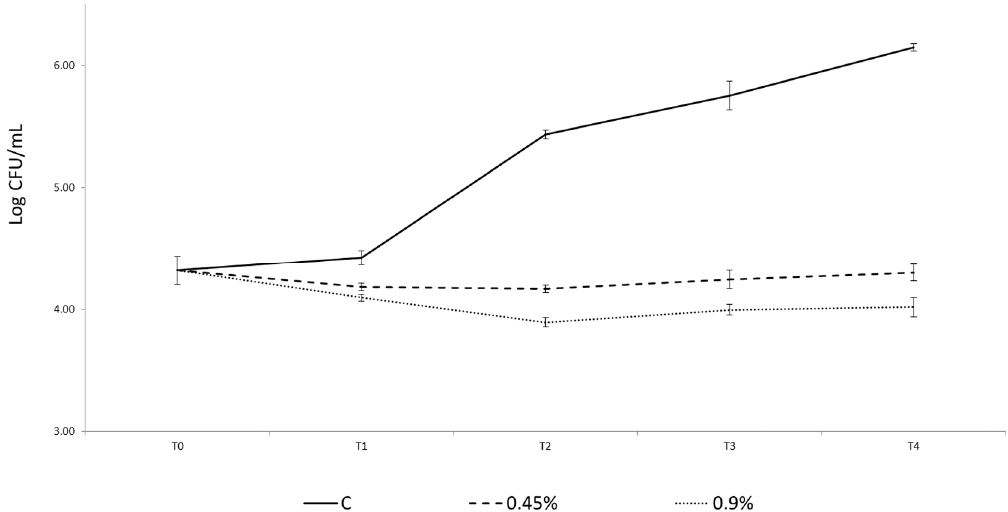
Figure 3. Behavior of Listeria monocytogenes during four days’ shelf life at refrigeration temperatures in salmon tartare without extract addition (C) ( ― ), with 0.45% ( v / w ) (---) and 0.9% ( v / w ) ( ∙∙∙∙∙ ) of A. platensis extract.